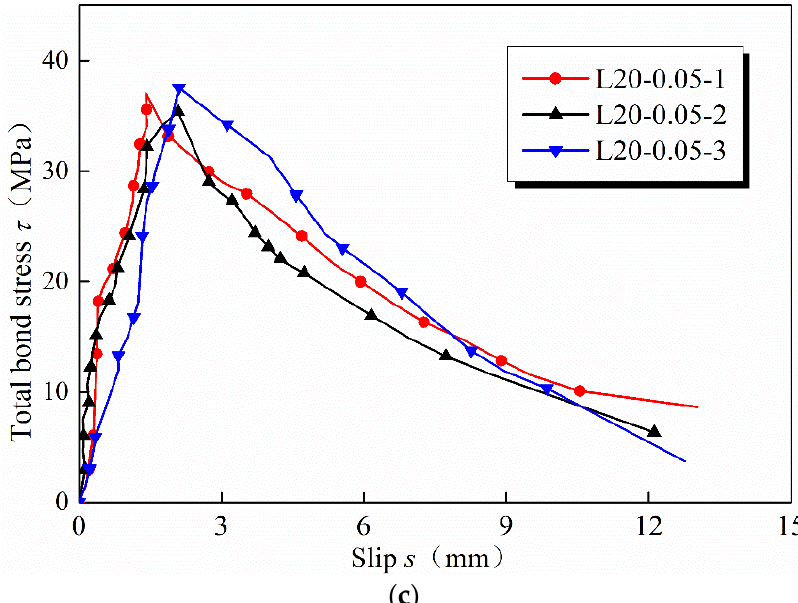
Figure 10. Bond and slip relationships in Specimens. ( a ) L12-0.05 ( b ) L16-0.05 ( c ) L20-0.05.